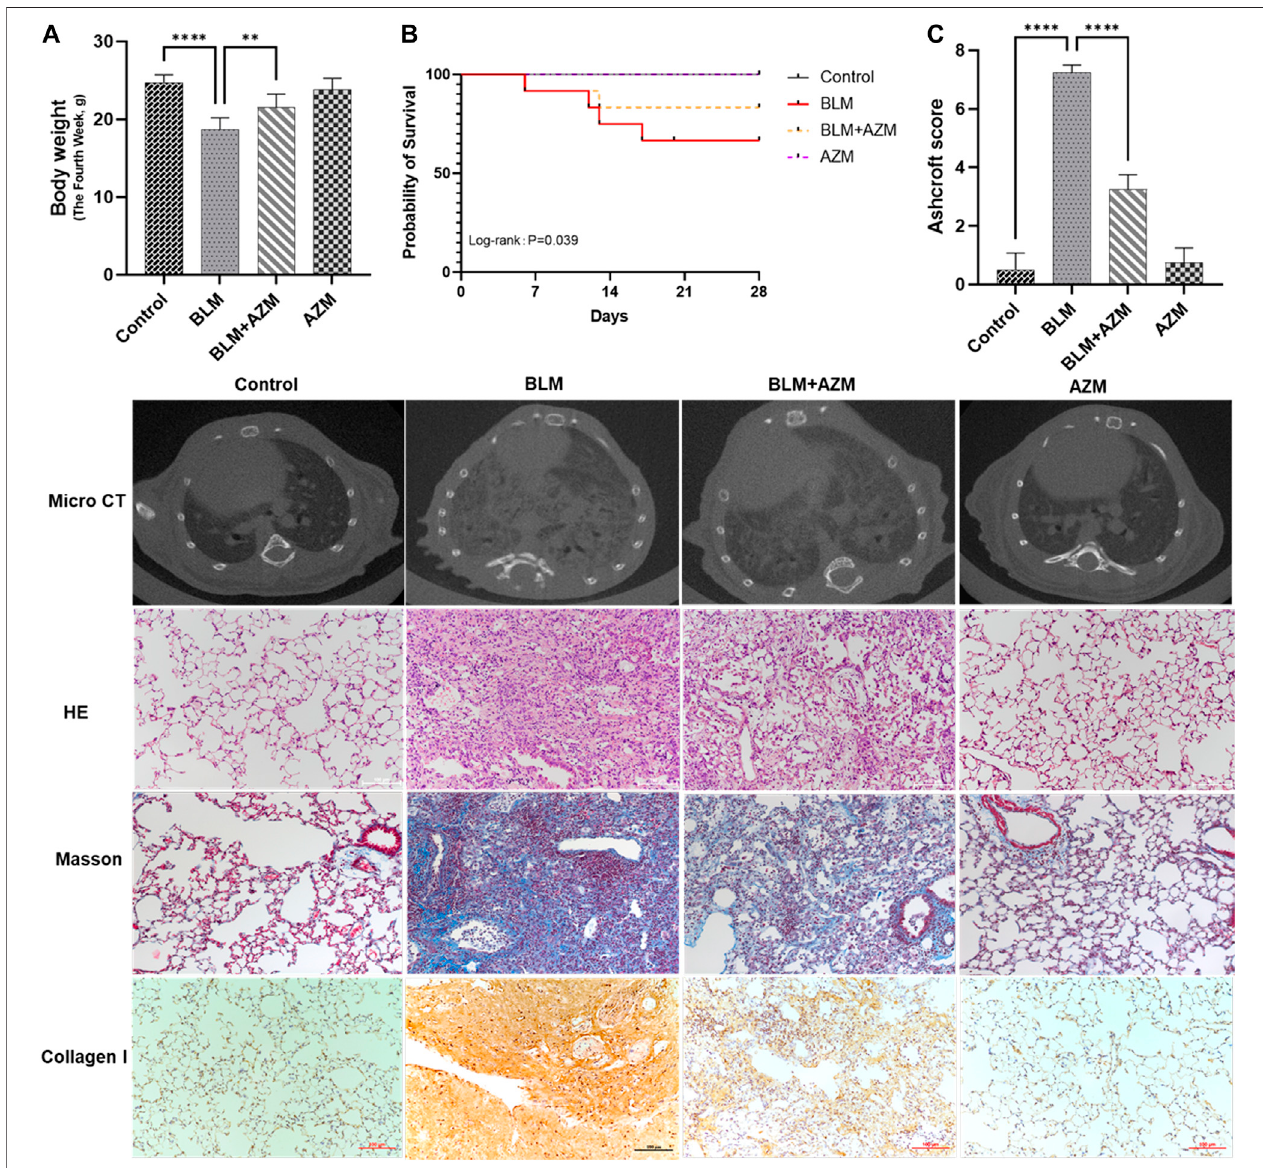
FIGURE1| Azithromycin(AZM)attenuatedbleomycin(BLM)-inducedpulmonary fi brosisinmice. (A) MicebodyweightsweremeasuredinDay28. (B) Survivalrate ofmiceindifferentgroups. (C) AshcroftscoreforthefourgroupswerebasedonHEstaining.TheotherimagesweremicroCTresults,HEstaining,Massonstaining,and collagen I staining in different groups ( × 200 magni fi cation; scale bars (cid:2) 100 μ m). Data were presented as the means ± SD. ** p < 0.01, **** p < 0.0001.